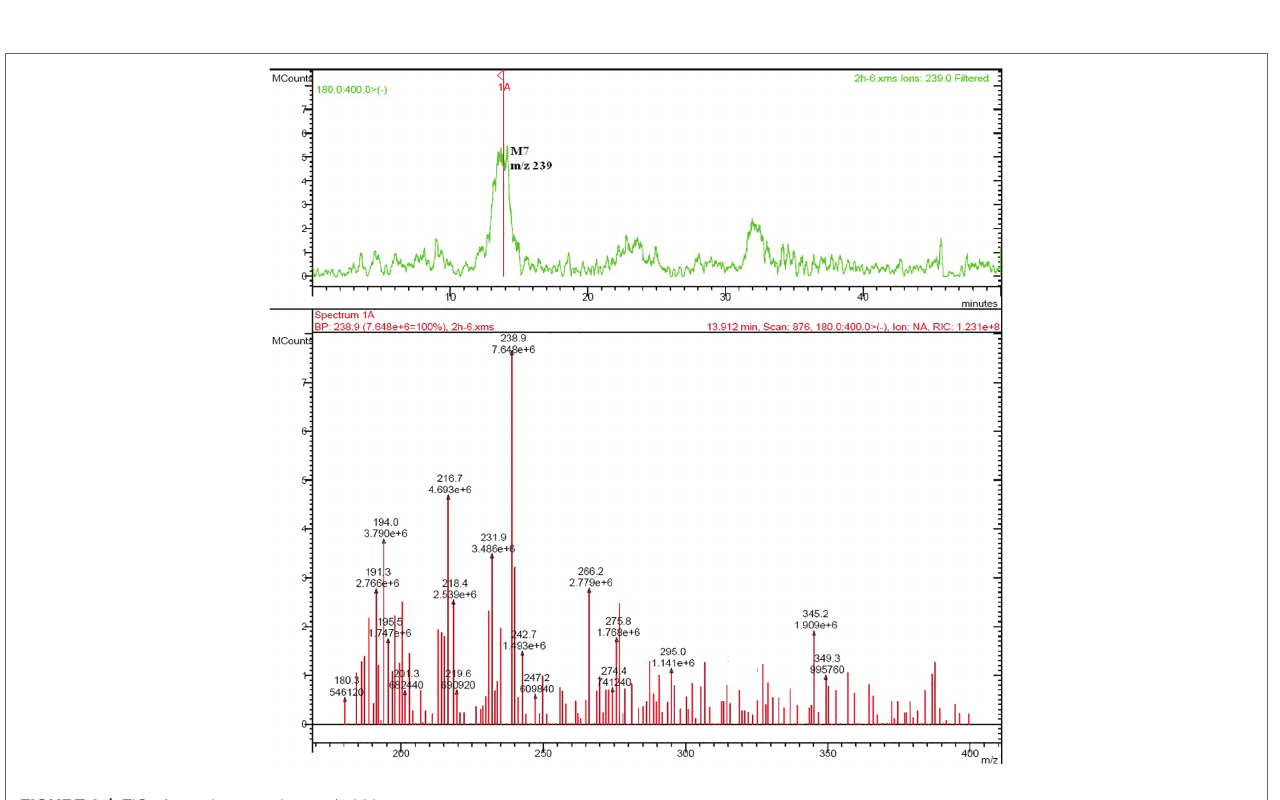
FIGURE 8 | EIC of rat urine sample at m/z